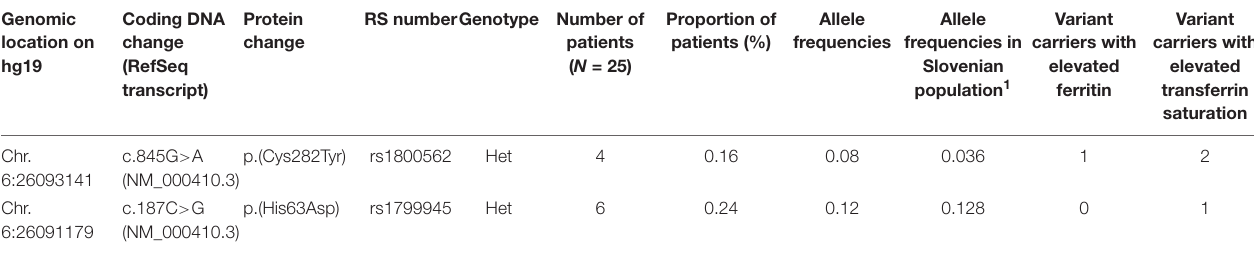
TABLE 2 | Distribution of HFE variants among IE patients and number of variant carriers with elevated ferritin and transferrin saturation. Genomic location on